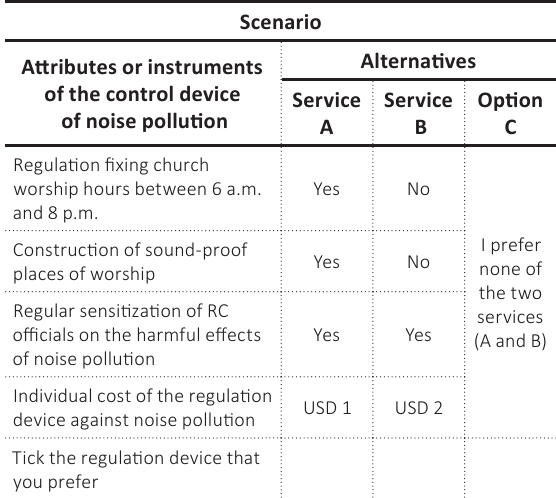
Table 2. Example of choice of profile